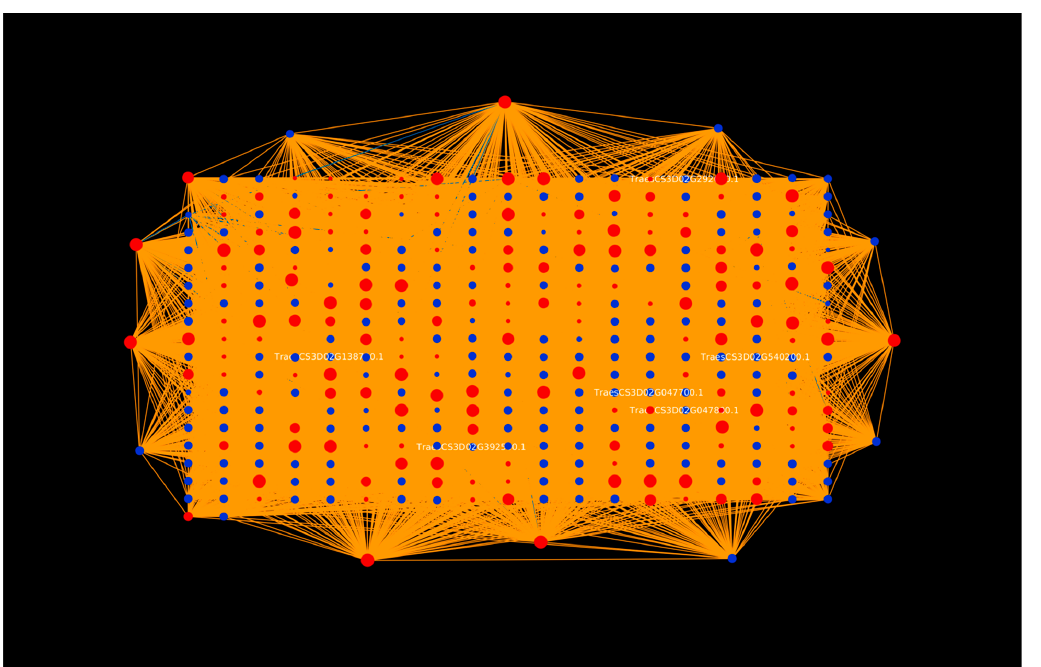
Figure 3. Visualization of top GO term (GO:0008171, O-methyltransferase activity) from the molecular function category. Blue nodes represent host proteins, red nodes are pathogen proteins. Orange edges depict the interactions from the interolog-based approach, while blue edges belong to the domain-based approach.